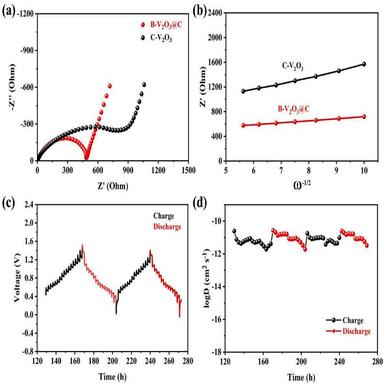
(a) EIS curves of B–V2O3@C and C–V2O3. (b) Linear relationship of impedance real parts (Z') and the reciprocal square root of the lower angular frequency (ω− 1/2) for the both samples. (c) Potential response during contributes to galvanostatic intermittent titration technique (GITT) test of B–V2O3@C at 50 mA g− 1 . (d) Logarithm of diffusion coefficient for Zn ion vs. voltage calculated based on foregoing GITT results.